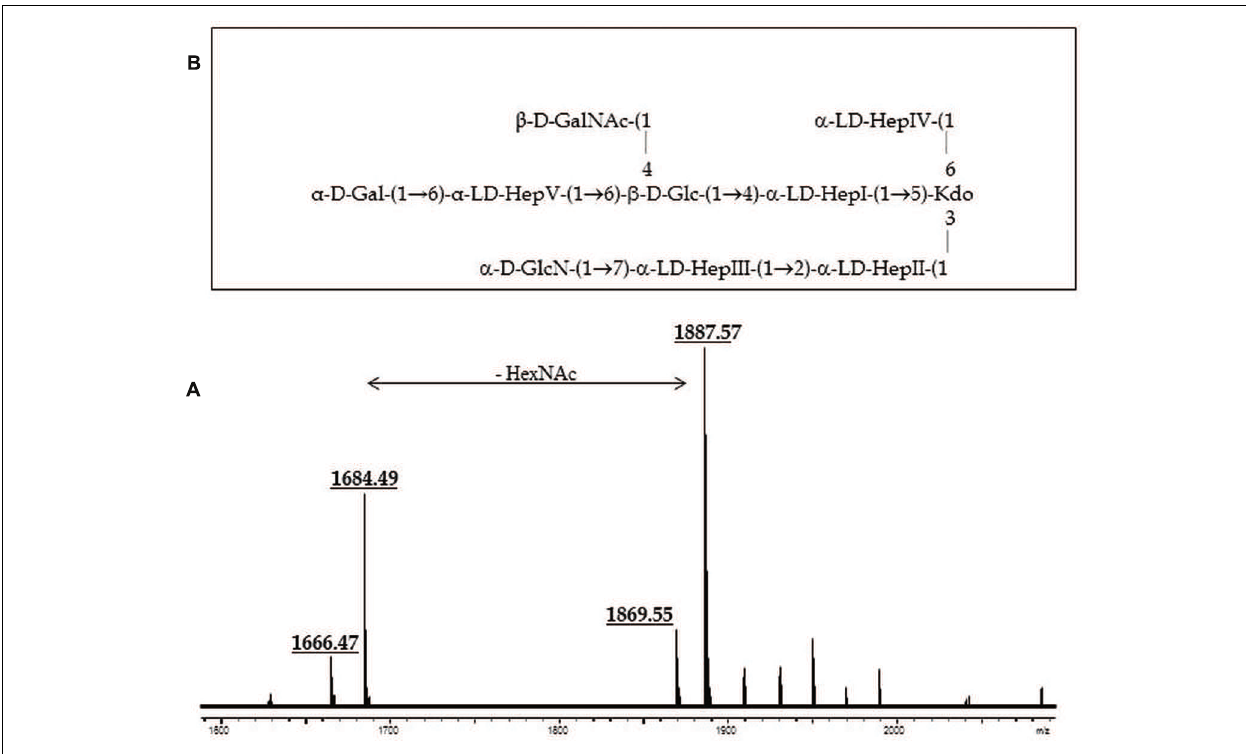
FIGURE 2 | (A) Positive-ion MALDI-TOF of purified LPS core from A. salmonicida subspecies masoucida strain CECT8967T. (B) Presumptive LPS-core structure of the same strain according to the previously published A. salmonicida A450 (Jimenez et al., 2009).